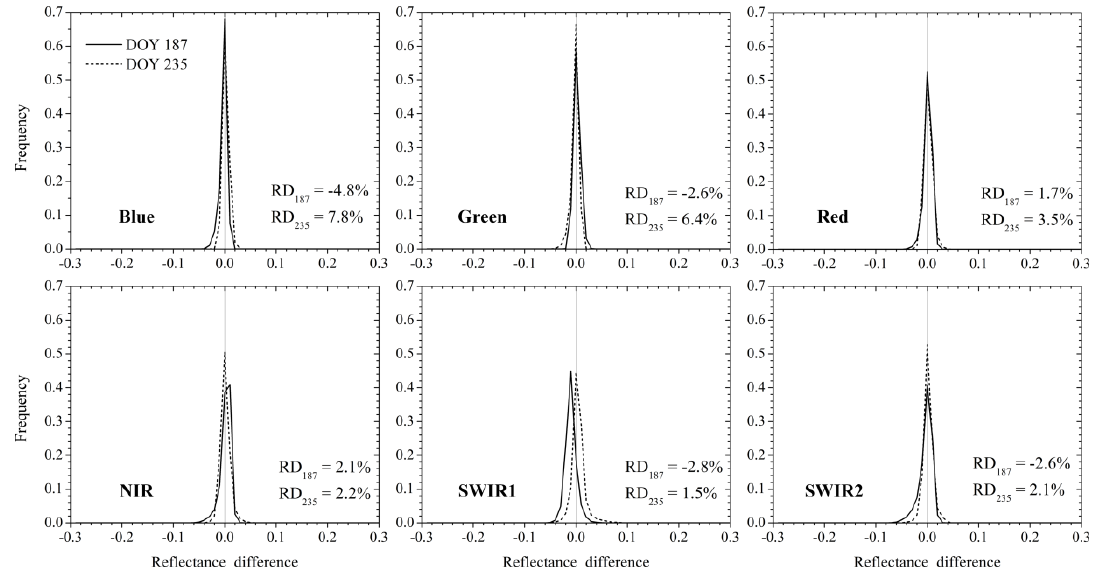
Figure 5. Histograms of residuals between the CACAO reconstructed reflectances and the Landsat 8 OLI observed reflectances on DOY 187 (solid lines) and 235 (dashed lines) for the different spectral bands. The statistics refer to the relative differences (RD).